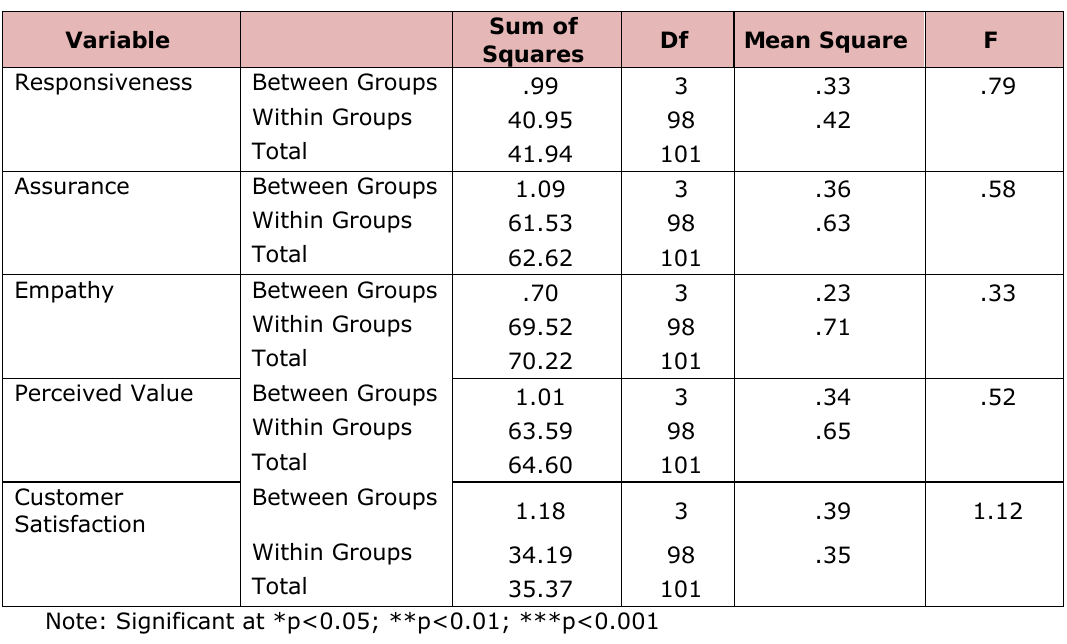
Table 3. ”The Results of One-Way ANOVA for the Difference between Age